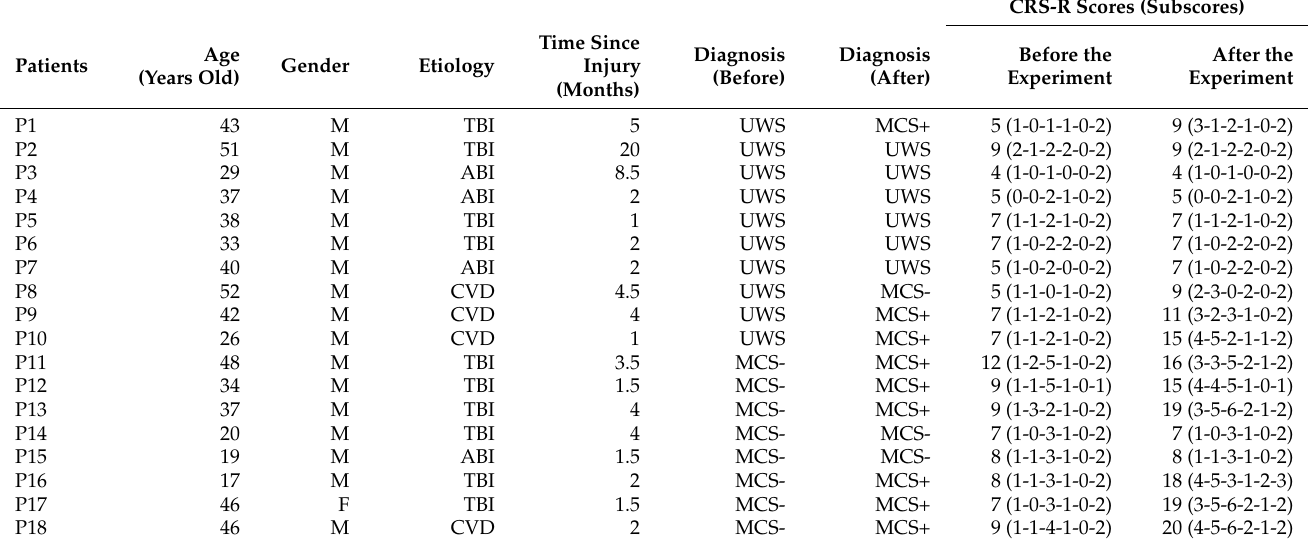
Table 1. Information and CRS-R scores for all